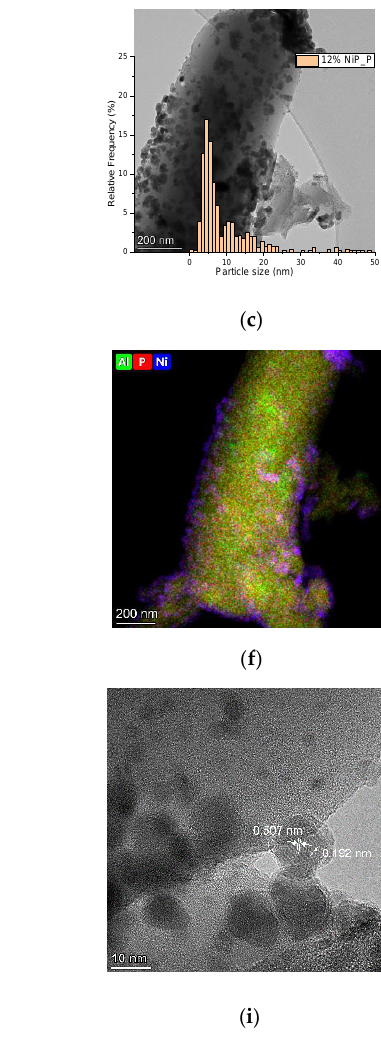
Figure 11. TEM images of: ( a , d , g ) 3% NiP_P; ( b , e , h ) 7% NiP_P; ( c , f , i ) 12% NiP_P. Figure 11a–c show TEM images and particle size distributions of NiP_P samples with different Ni contents. All the distributions have a maximum at 4.5 nm. As the Ni